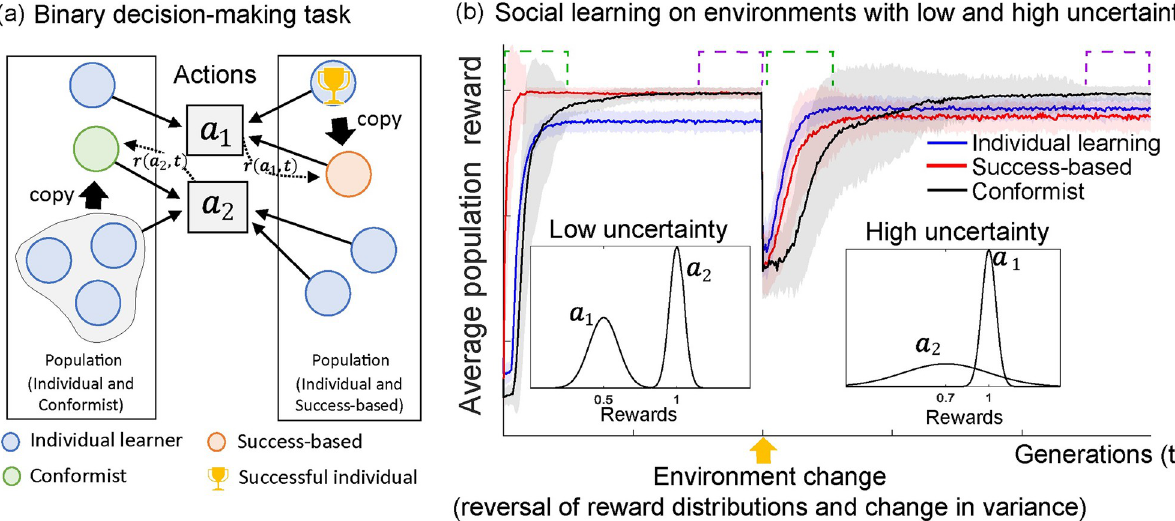
Fig 1. The learning process of populations of individual and social learners on a binary decision-making task. (a) A population of individuals perform a binary decision-making task based on individual and social learning strategies and collect their rewards ( r ( a individual learners, modeled by a the � -greedy algorithm [32] (see Section 4.2), can perform their actions based on their decision models that can be improved by experience. The social learners use success-based or conformist strategies to copy the actions of successful individuals or the majority respectively (see Section 4.3). (b) Binary decision-making task (2-armed bandit) is iteratively performed for a certain period of time with specified reward distributions that are unknown to the individuals. At some point, an environment change occurs by changing the reward distributions (a.k.a reward reversal). In earlier stages of the process (initial and after environment change, shown in green dash lines), populations with success-based social learning strategy achieves higher average population reward faster relative to the conformist strategy. In later stages of the process (shown in purple dashed lines), populations with success-based social learning strategy achieves higher average population reward in environments with low uncertainty, whereas, populations with conformist social learners achieves higher average population reward in environments with high uncertainty.